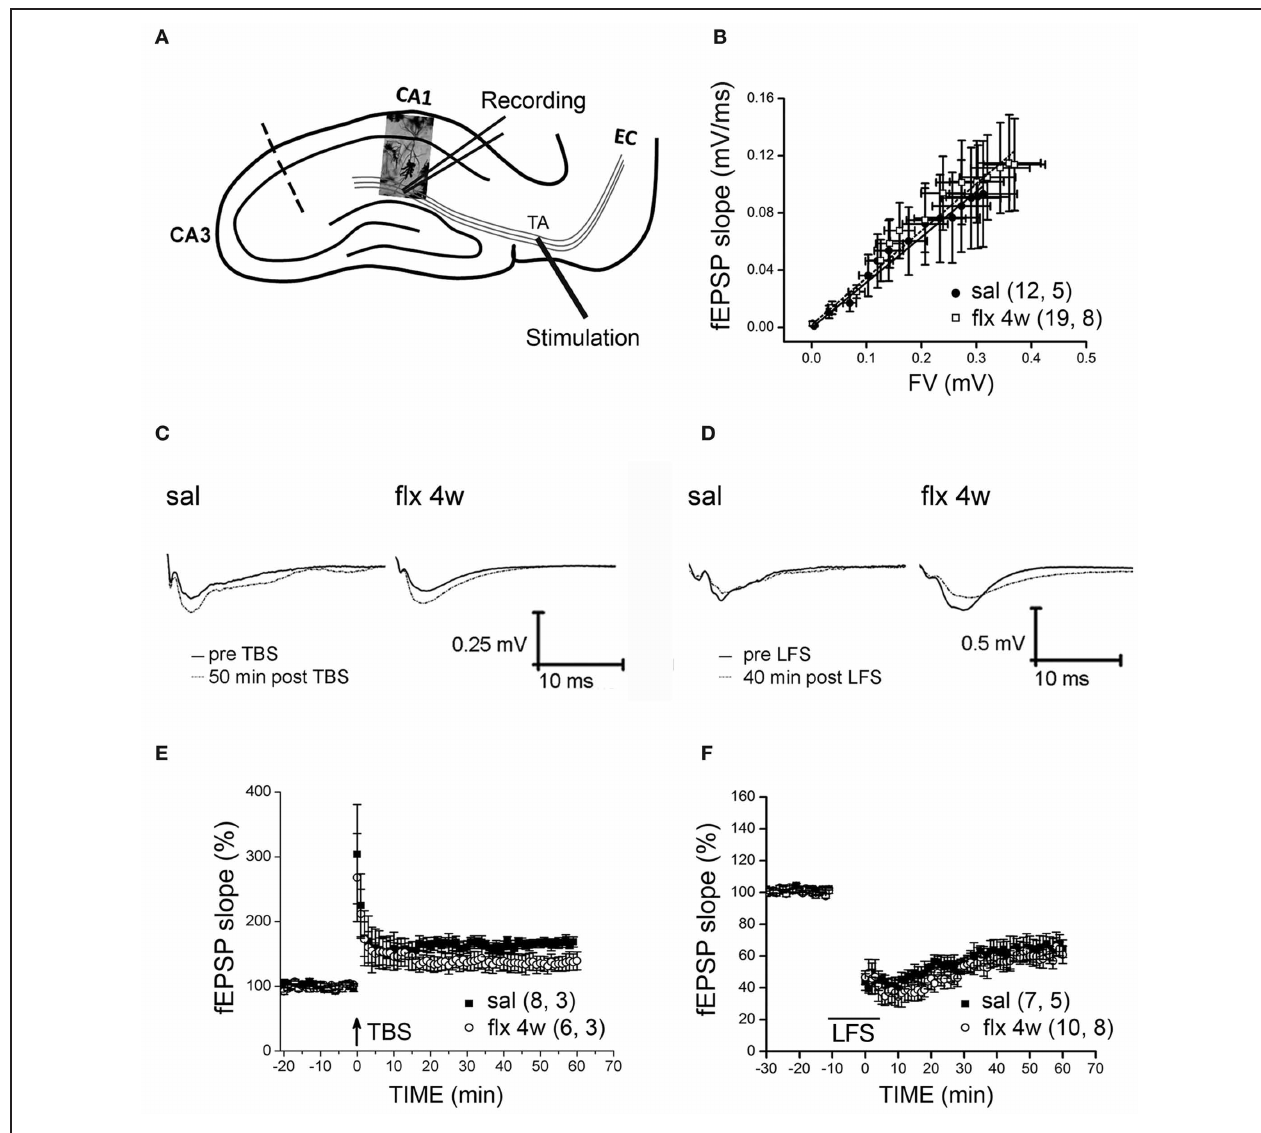
FIGURE 4 | Four weeks of fluoxetine administration does not affect synaptic plasticity at perforant pathway-CA1 synapses. Experiments were performed in slices from saline- (sal) and fluoxetine- (flx 4 weeks) treated rats. (A) The diagram shows the stimulating electrode inserted into the temporoammonic pathway (TA) and the recording electrode in the CA1 s.l.m . EC, entorhinal cortex. The dashed line indicates the place of the physical de-afferentation of Schaffer collateral inputs to CA1. (B) The fEPSP slopes vs. increasing presynaptic fiber volley (FV) amplitudes were plotted to analyze the input/output curves. No significant difference between saline- and repetitive fluoxetine-treated rats was found after data were fit to a linear